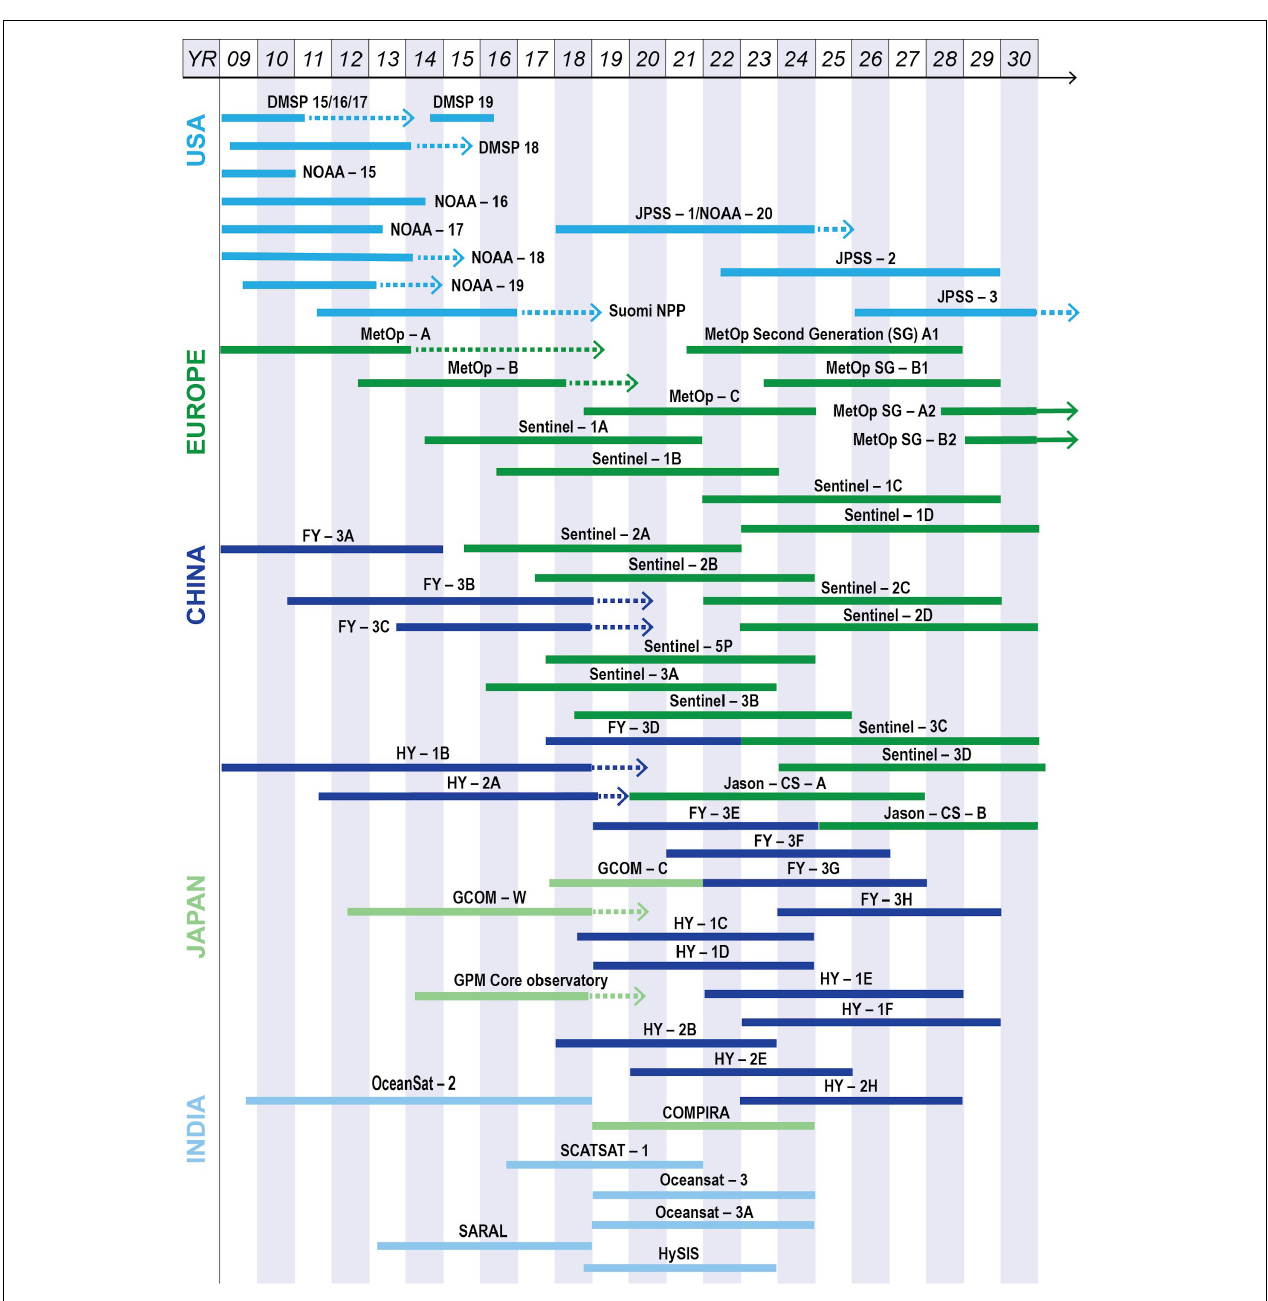
FIGURE 3 | A schematic sketch of major operational polar-orbiting satellites, showing the wealth of data from which blended products can be generated in response to increased needs on spatial-temporal resolutions and accuracy for research and societal applications.